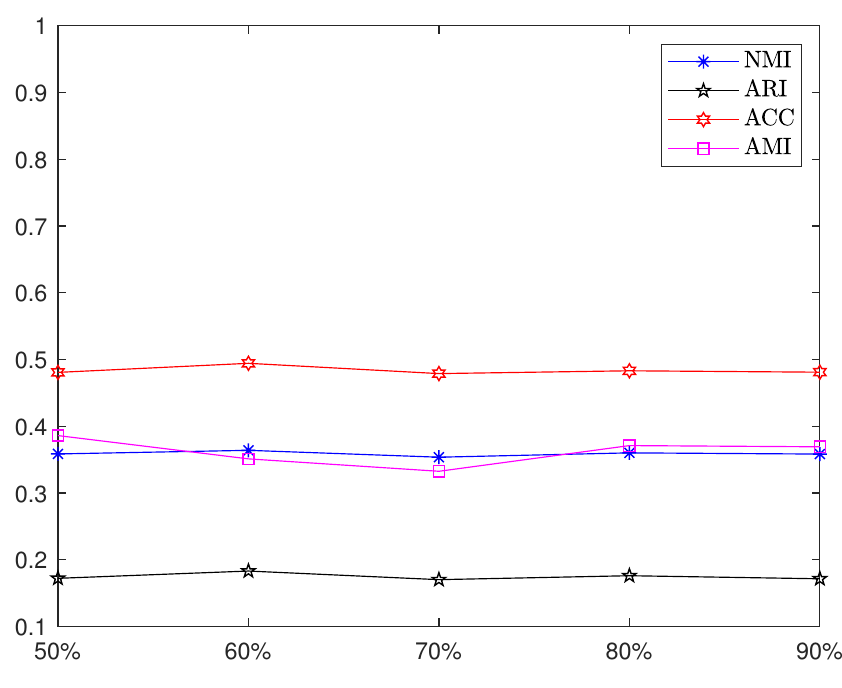
Figure 2. Results of Cardiotocography by 3WESP.